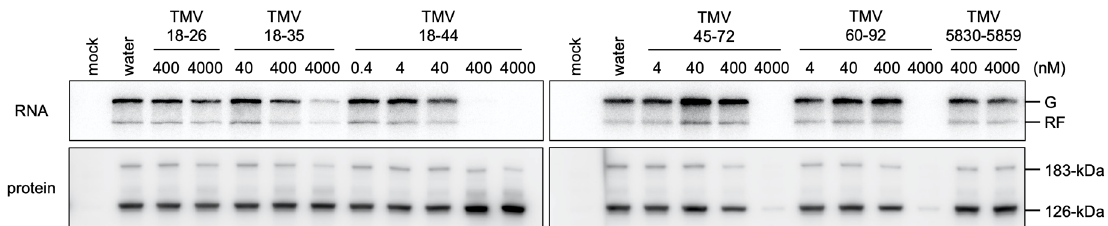
Figure 3. Effects of the addition of small RNA fragments on cell-free translation and replication of TMV RNA. In vitro TMV RNA translation–replication assay was performed in the presence of small RNA fragments at various concentrations. De novo -synthesized TMV RNA was analyzed by urea-PAGE and autoradiography (upper panel). The accumulation of TMV replication proteins after translation reaction was examined by SDS-PAGE and Western blotting using antisera against replication proteins (lower panel). Positions of the genomic (G) and replicative form (RF) RNAs and 126-kDa and 183-kDa replication proteins are shown on the right.